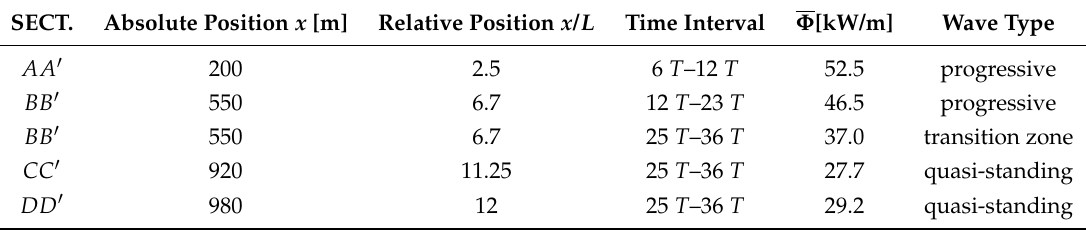
Table 4. Mean energy flux in the six sections of Figure 8, averaged in the time intervals shown in the fourth